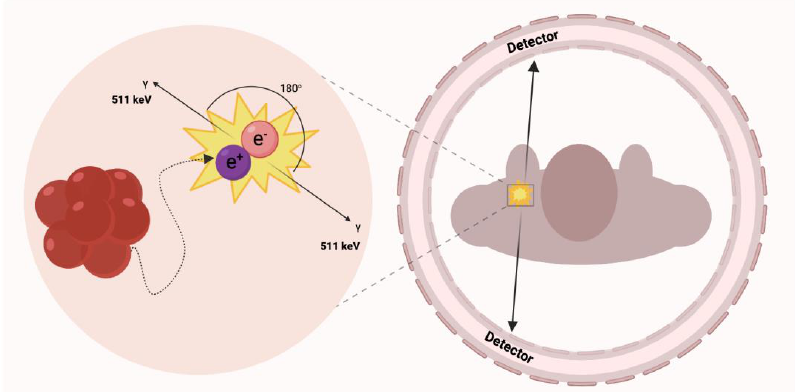
Figure 1. Simplified schematic of positron annihilation. At low energy, the emission of the positron particle results in the annihilation of the electron-positron pair and the production of energetic photons. Ideally, two photons are formed in a linear arrangement with an electron or positron resting energy of 511 keV.